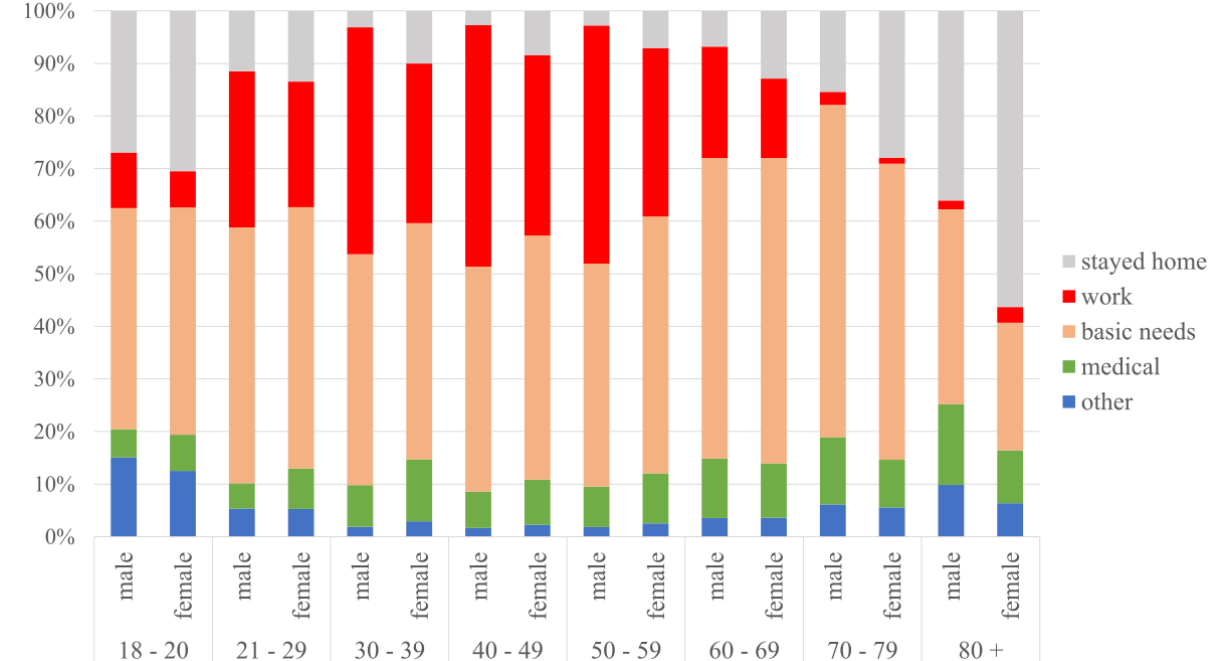
Figure 2. Reasons for leaving the home by gender and